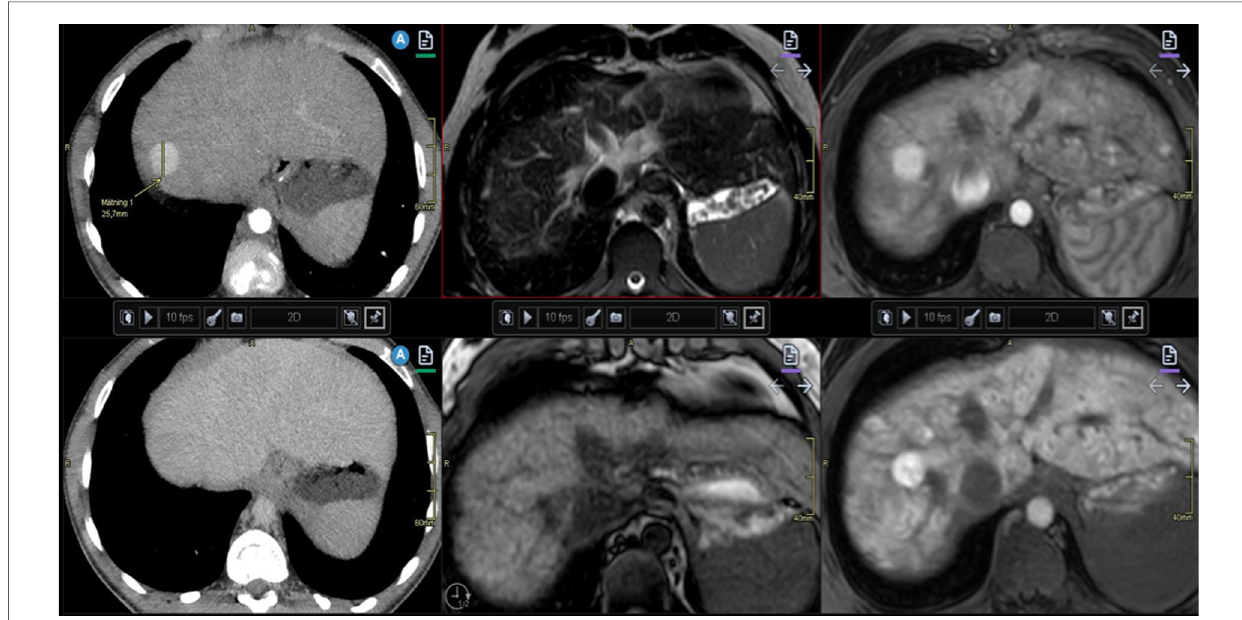
FIGURE 7 Illustration of liver nodules in a 20-year-old man with pulmonary atresia and a Fontan circulation. Increased hepatic serological marker, and alkaline phosphatase was observed. Multiphase contrast-enhanced CT revealed a nodule of 2.5 cm in diameter in segment eight with arterial enhancement (upper left) and apparent washout on portal venous phase (lower left). Follow-up MRI with hepatocyte-speci fi c contrast displays low signal on T2- weighted (upper middle) and isointense signal on T1 (lower middle). Arterial enhancement (upper right) and slightly heterogeneous hyper- enhancement on late hepatocyte phase (lower right). Note the heterogenous congestion and multiple small surrounding nodules in this late phase. These are both benign and malign features. Biopsy in this case was considered dif fi cult due to the high position of the nodule under the diaphragm. Close monitoring was recommended. CT, computed tomography; MRI, magnetic resonance